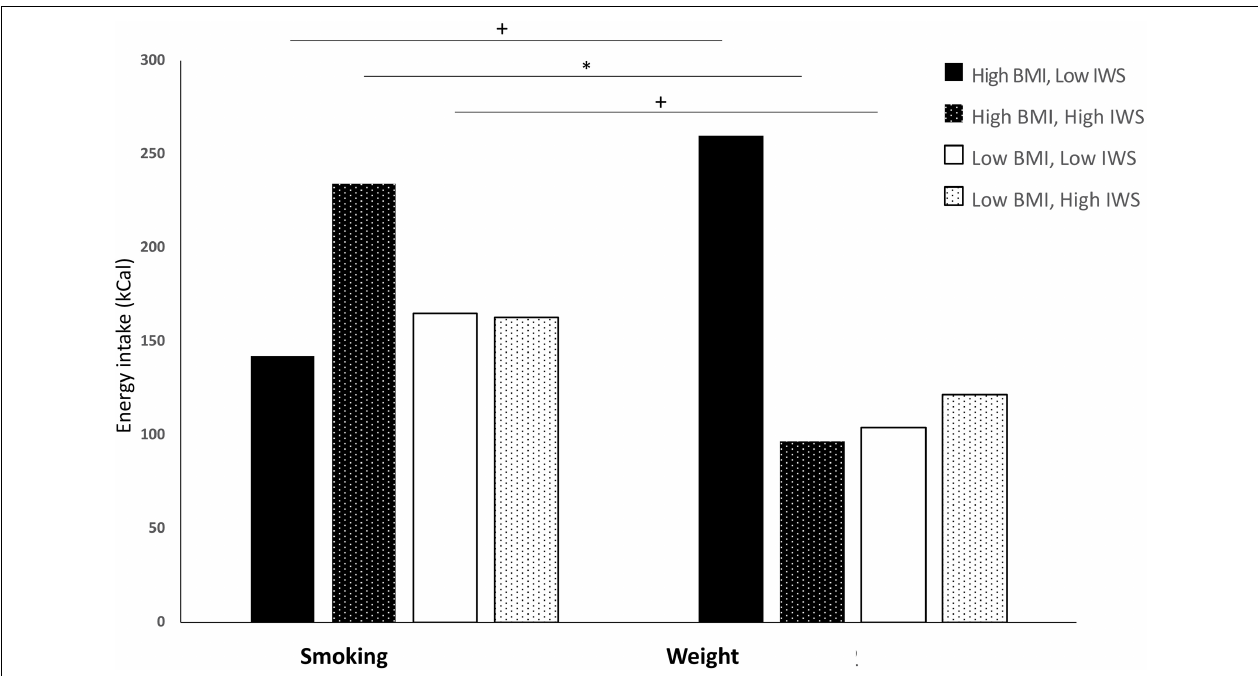
FIGURE 2 | Impact of experimental condition on total energy intake by level of internalised weight stigma and weight status. High BMI ≥ 25 kg/m 2 ; Low BMI < 25 kg/m 2 . High and low internalised weight stigma designated by upper (5.5) and lower (2.5) quartiles of modified Weight Bias Internalizstion Scale score range, respectively. BMI, Body mass index; IWS, internalised weight stigma. ∗ p < 0.05. + p <